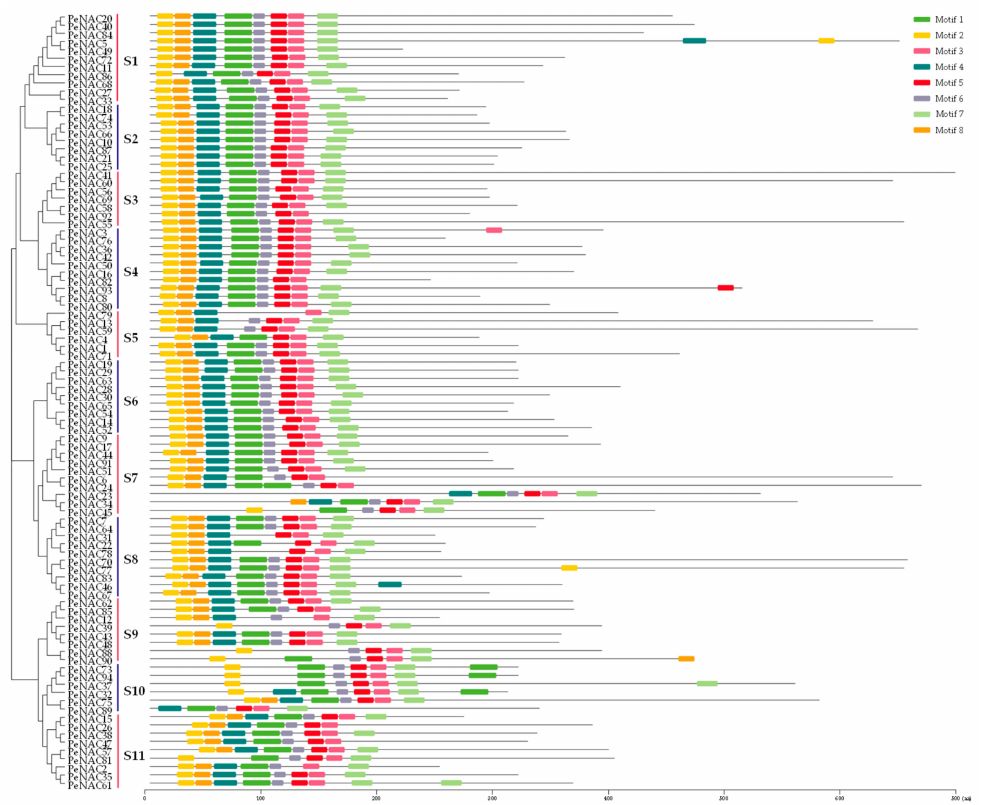
Figure 2. Schematic representation of the conserved motifs in PeNACs. Motifs were identified using the MEME online tool. Each motif was indicated by di ff erent colored blocks (motif 1–motif 8). The position and length of each colored box represented the actual motif